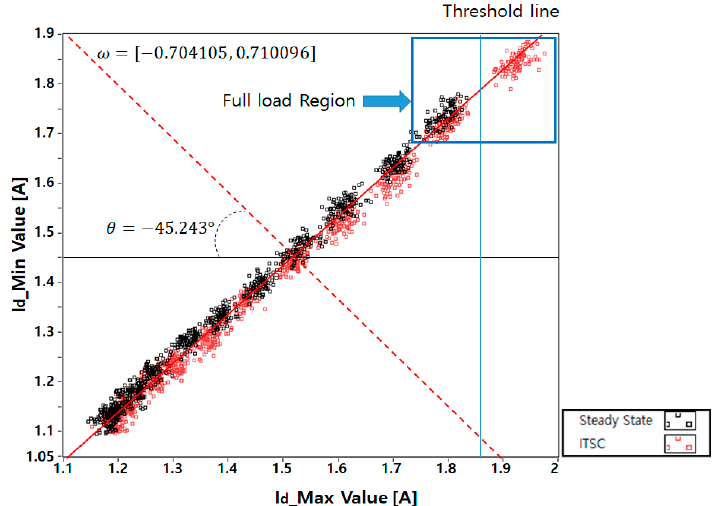
Figure 15. LDA application and critical line according to inter-turn short circuits (ITSC).